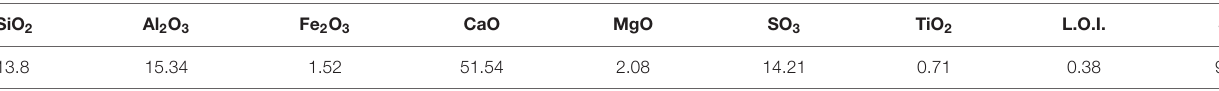
TABLE 2 | Chemical composition of the used HB-CSA cements (L.O.I. = loss on ignition).